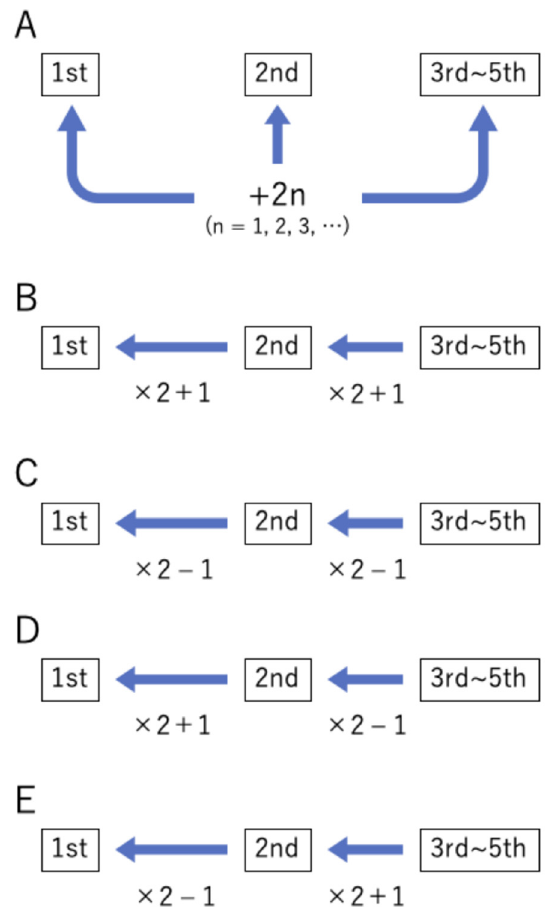
Figure 1. Change patterns of the filter size of the convolution layer. [( A – E ): the change patterns of group name (groups A to E )].